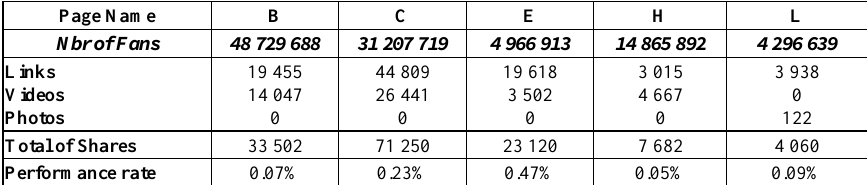
Table 3. Results Analysis of « Shares » on posts sharing in Facebook pages.